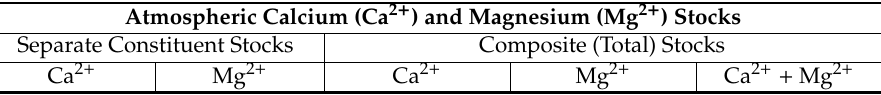
Table 3. Conceptual overview of the accounting framework for a systems-based approach in the ecosystem services valuation of various atmospheric magnesium deposition flows used in this study (adapted from Groshans et al., 2018 [15]). Biophysical Accounts (Science- Based)